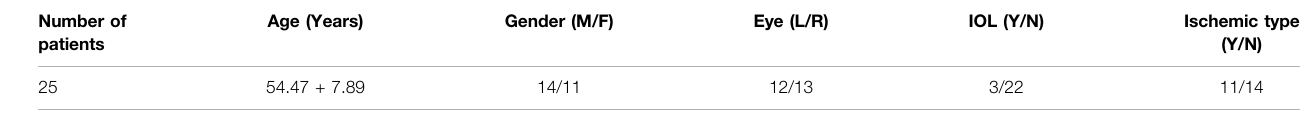
TABLE 1 | Demographic characteristics of the study population. Number of patients